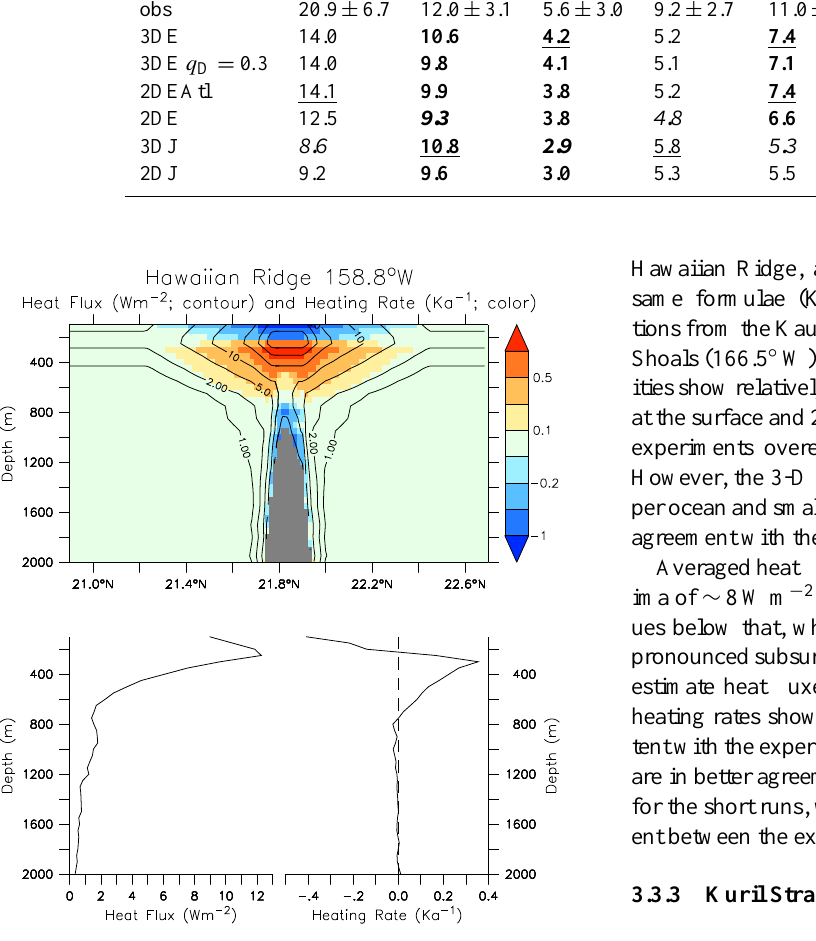
Fig. 8. As Fig. 7 but for the diffusive vertical heat flux (contour lines at 1, 2, 5, 10, 20, 30, and 40Wm − 2 shown in the upper panel) and heat flux convergence (color; units are Kelvin per year). Bottom panels show horizontally averaged